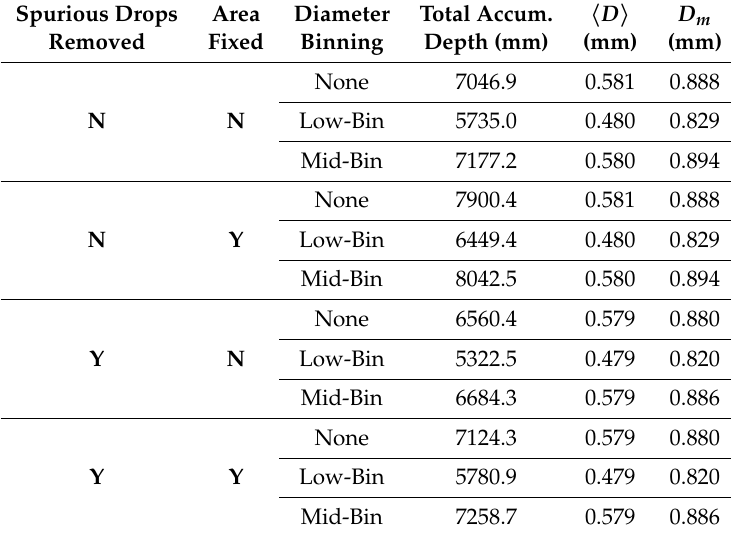
Table 2. Summary of ensemble data under different processing paradigms. The entire data set had 202,555,318 total drops, of which 194,089,999 were retained after removing spurious drops. (cid:104) D (cid:105) indicates mean diameter whereas D m specifies mass-weighted mean diameter. When binned, constant bin widths of 0.2 mm were used. Low-Bin indicates reported diameters were rounded down to the lower bound of the associated diameter bin, whereas mid-bin assigned drop diameters at the midpoint of the associated